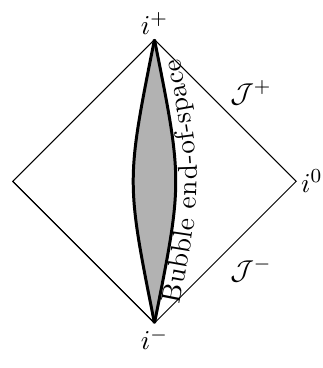
Figure 2 . Penrose diagram of a topological